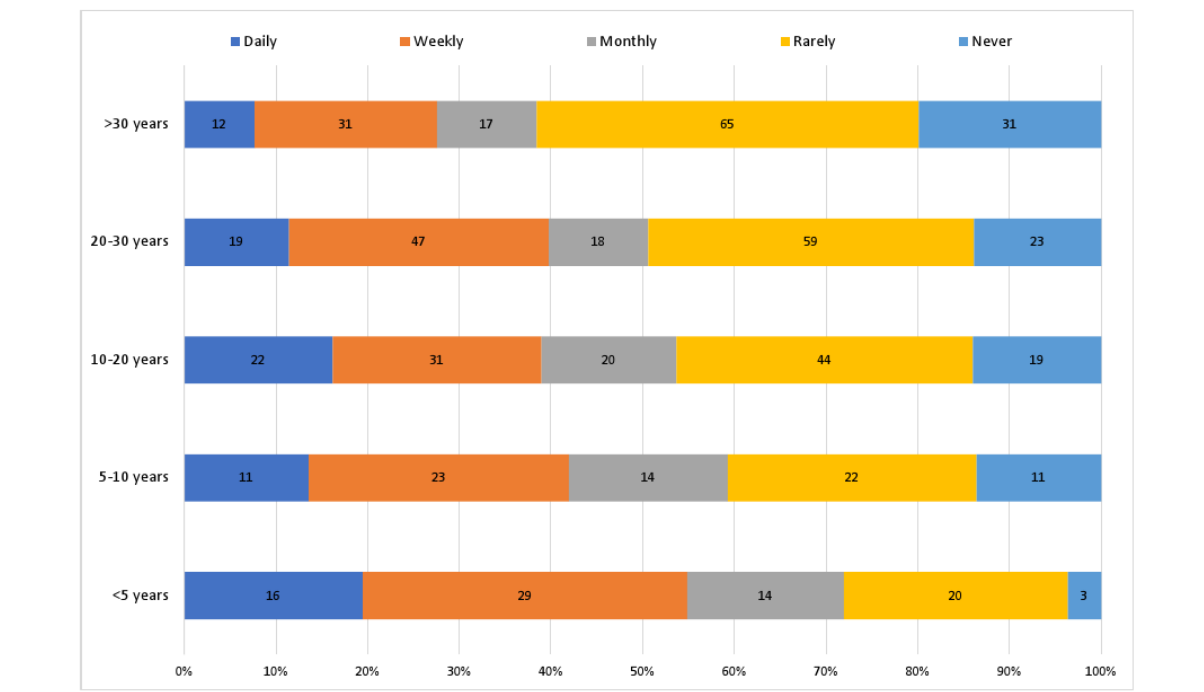
Figure 1. Frequency of app recommendation by years practiced.